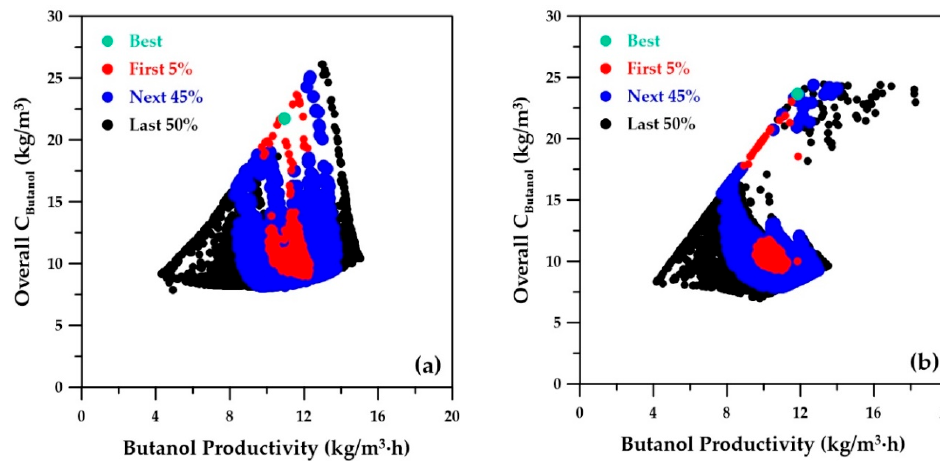
Figure 8. Plots of the Pareto-optimal overall butanol concentration versus butanol productivity for the integrated fermentation–membrane pervaporation system: ( a ) ANN metamodels; ( b ) actual integrated acetone–butanol–ethanol (ABE) fermentation simulation.